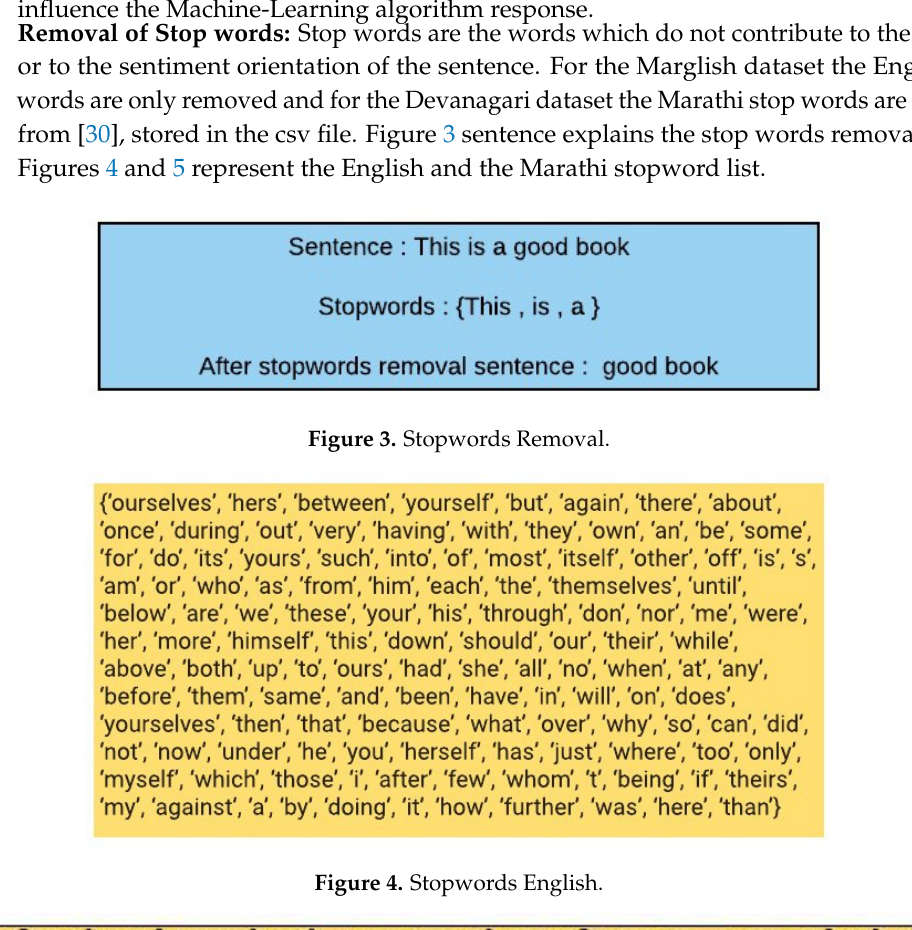
Figure 4. Stopwords English.